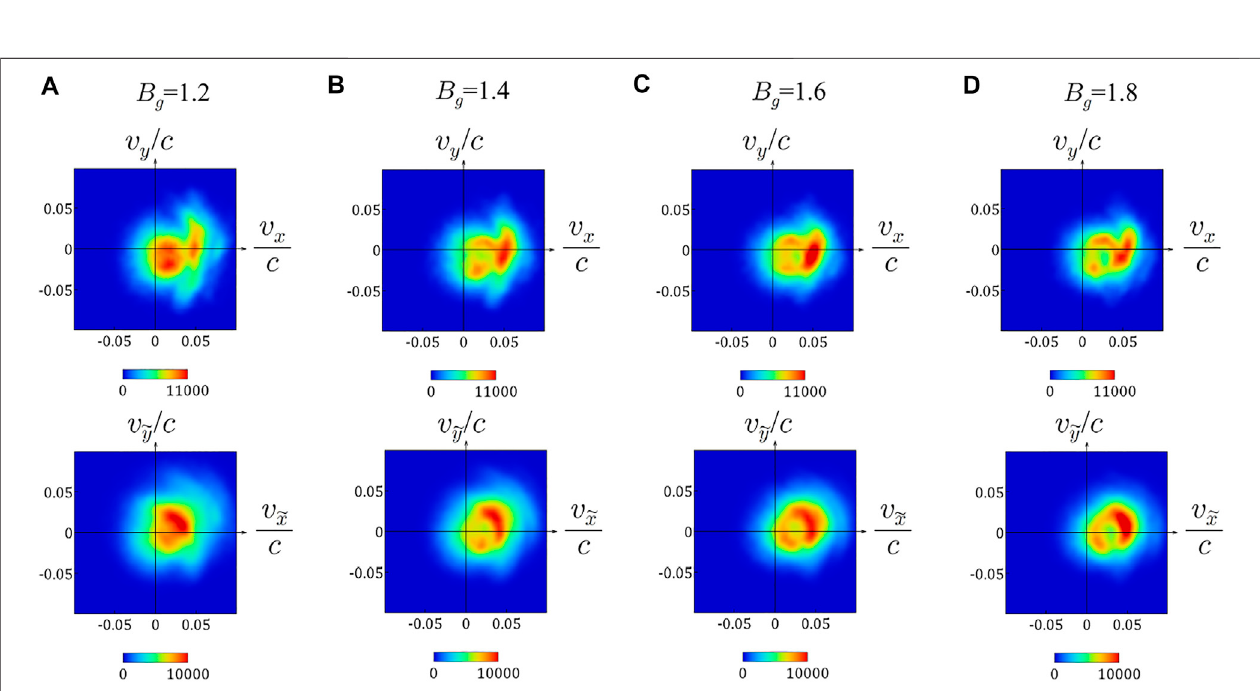
FIGURE 6 | Ion velocity distributions (A) : in the boxed area (d1) and (B) : in the boxed area (d2) indicated in Figure 5C . In both panels, pseudo-Maxwellian distributions are seen at the central part near ( v x , v y ) = (0, 0).